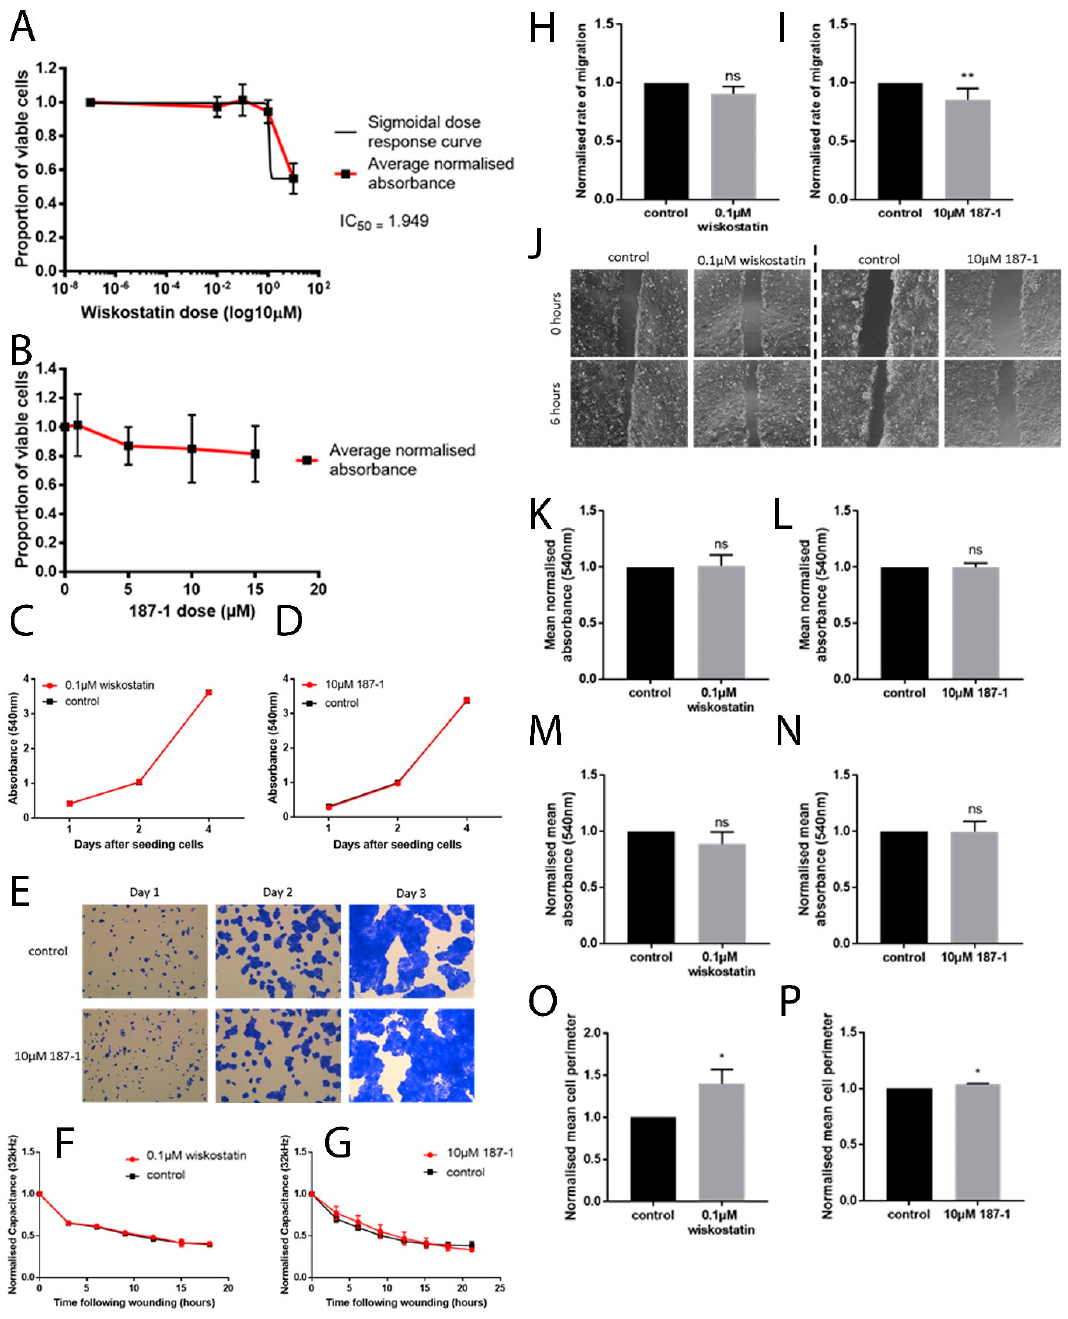
Figure 3. The effect of nWASP inhibition on the HaCaT cell behaviour. Dose–response curves ( A , B ). HaCaT cells treated with 0.1 µ M wiskostatin ( C ) or 10 µ M 187-1 ( D ). Average absorbance ± SD is presented, representative data are shown and n = 5 replicates were in each independent repeat. Representative images of crystal-violet-stained cells ( E ). HaCaT cells following an electrical wounding treated with 0.1 µ M wiskostatin ( F ) or 10 µ M 187-1 ( G ). The effect of wiskostatin and 187-1 on the rate of migration of HaCaT cells: 0.1 µ M wiskostatin ( H ) and 10 µ M 187-1 ( I ). Normalised rate of migration + SD is presented. Representative images of the scratch wound at 0 and 6 h are also shown ( J ). The 0.1 µ M wiskostatin ( K ) and 10 µ M 187-1 ( L ) treatment results are shown. The change from the control is presented with the mean + SD shown. The effects of 0.1 µ M wiskostatin ( M ) and 10 µ M 187-1 ( N ) on the normalised absorbance, and the effects of 0.1 µ M wiskostatin ( O ) and 10 µ M 187-1 ( P ) on the spread of HaCaT cells. * indicates statistical significance from 0 h to each subsequent time point (* p < 0.05, ** p < 0.01, ns: not